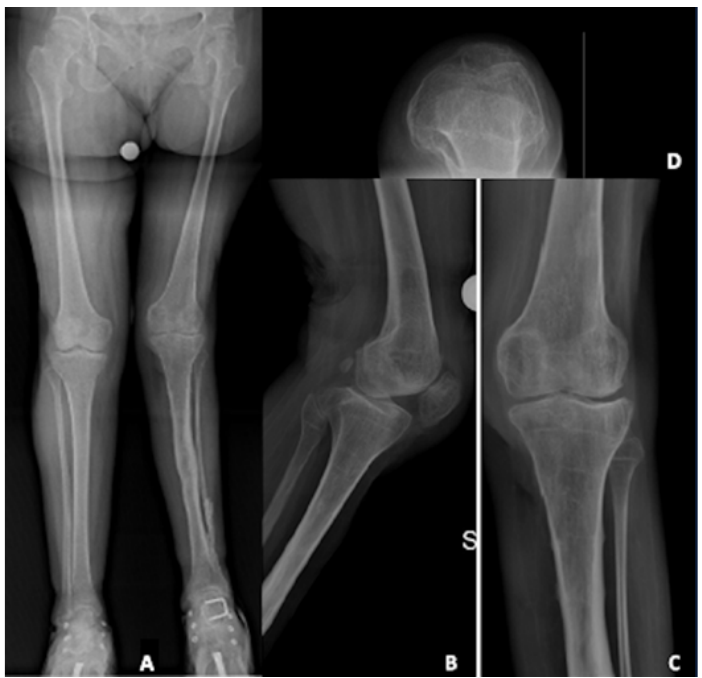
Figure 1. Pre-operative X-rays evaluation: ( A ) long-leg weight-bearing view; ( B ) lateral view; ( C ) antero-posterior view; ( D ) patellar view.